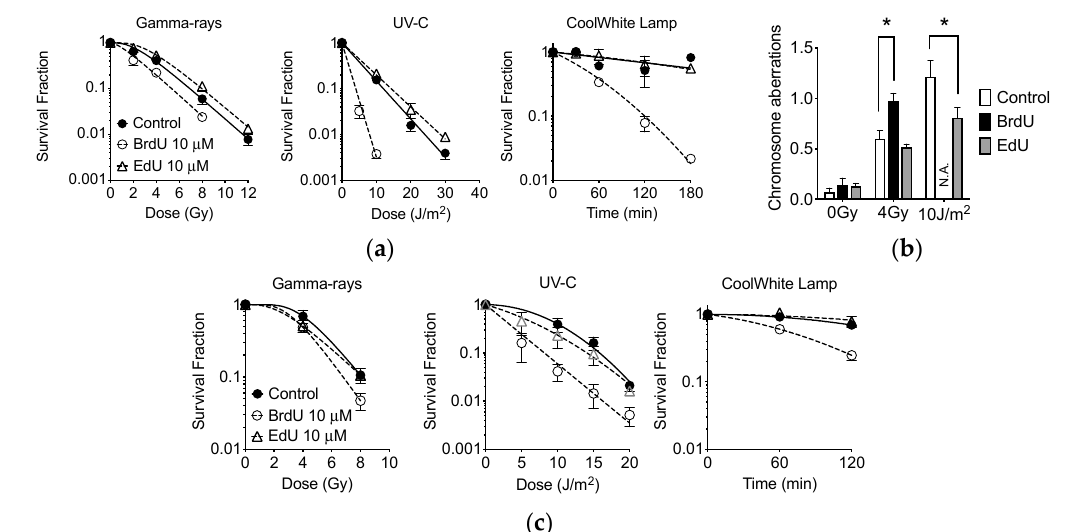
Figure 9. Sensitization to photon exposure with 10 μ M BrdU and EdU treatment. ( a ) CHO cell survival curves with gamma-rays, UV-C, and light from fluorescent lamp. Closed circles indicate control, open circles indicate BrdU treatments, and open triangles indicate EdU treatment; ( b ) chromosome aberration analysis. Open bars indicate control. Black bars indicate BrdU treatment. Grey bars indicate EdU treatment; ( c ) A549 cell survival curves with gamma-rays, UV-C, and light from fluorescent lamp. Errorbarsrepresentthestandarderrorofthemeanofthreeindependentexperiments. One-wayANOVA, Dunnett’s Multiple Comparison Test was performed to provide p -values. (*) denotes significance against control within each cell group ( p <